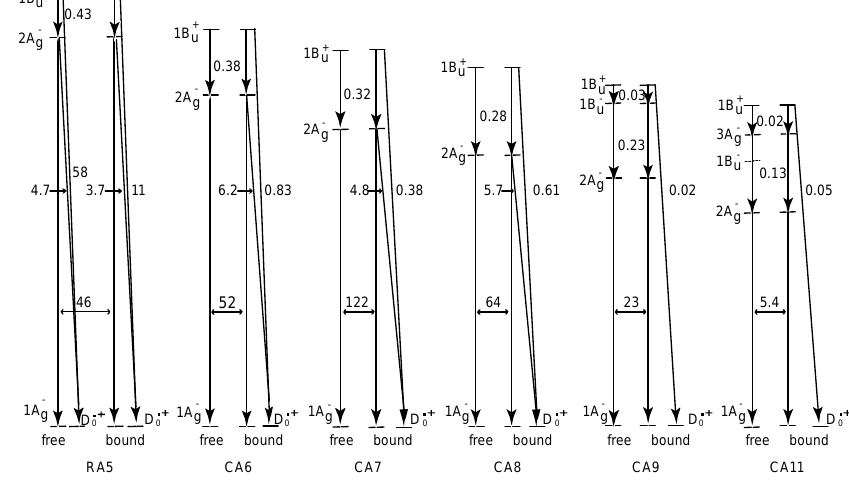
Figure 9. The pathways of internal conversion and electron injection for the RA and CA nanoparticles in suspension. The time sensitizers free in solution and bound to TiO 2 constant for each pathway is shown in picoseconds (reprinted with permission from [11] © 2005, American Chemical